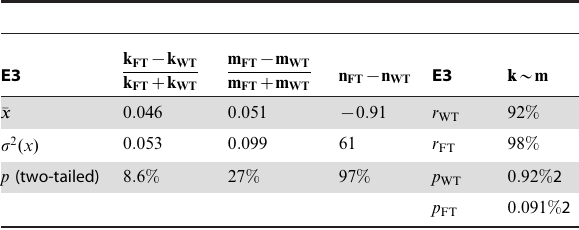
Table 6. Results of group E3 when the wrist was held in a constant posture by a cuff.